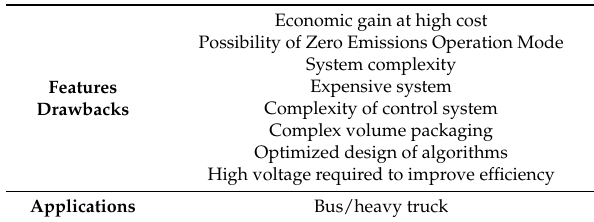
Table 4. Parallel Hybrid Configuration